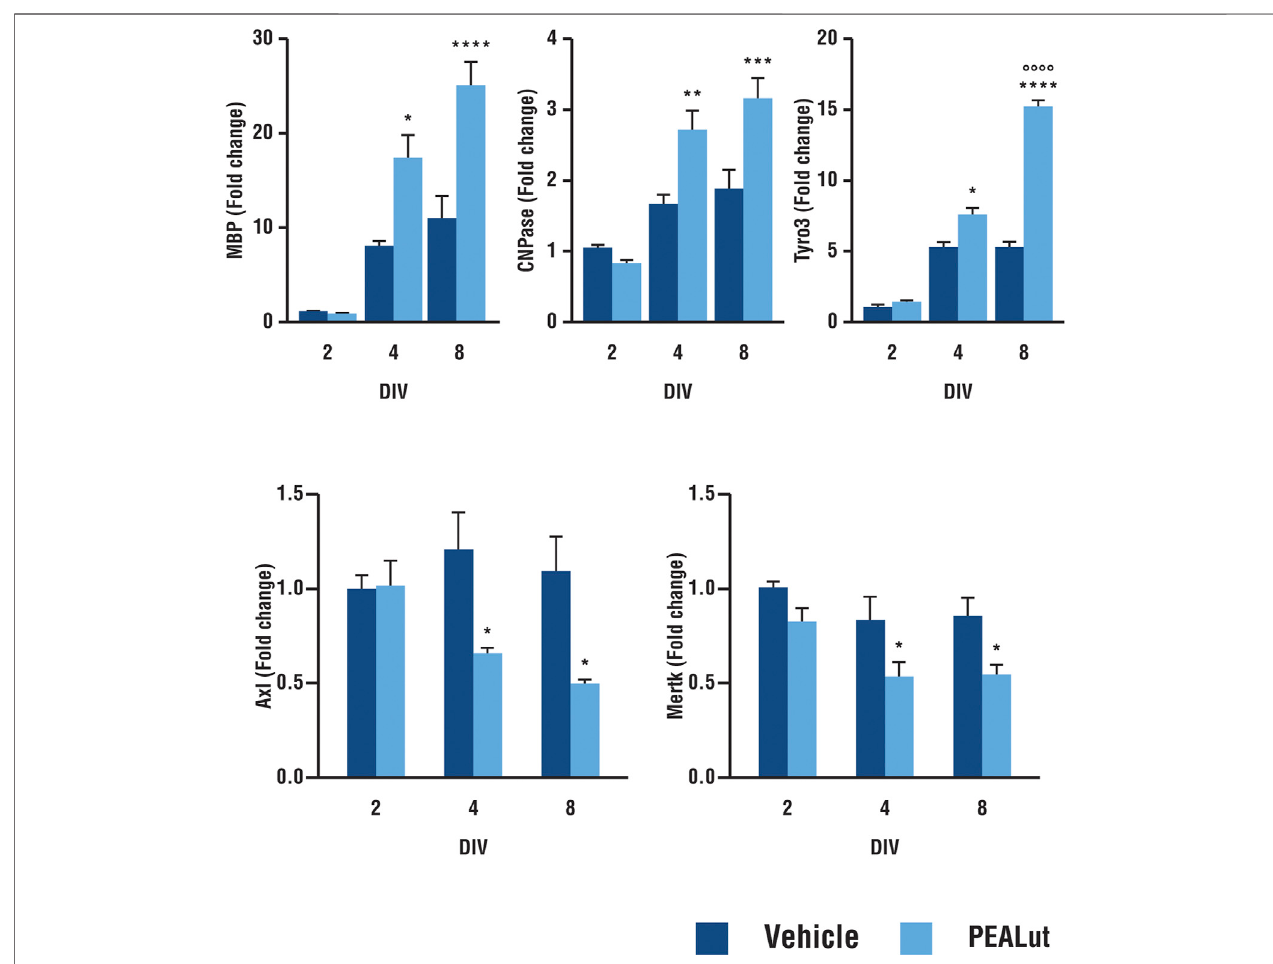
FIGURE1| Time-dependentincreaseinexpressionofMBP,CNPase,Tyro3,AxlandMertkmRNAsinPEALut-treatedOPCs.PEALuttime-dependentlyincreases expression of MBP, CNPase and Tyro3 in differentiating OPCs, while it induces a reduction of Axl and Mertk mRNAs. Cultures of OPCs were treated on the plating day (DIV 1) with 10 μ M PEALut and processed at DIV 2, 4, and 8 for real-time PCR. Data from two separated experiments (6 values) are expressed as fold-increase with respect to the control (vehicle) at DIV 2 and are means ± SEM. Data were analyzed with two-way ANOVA followed by post hoc Holm-Sidak ’ s multiple